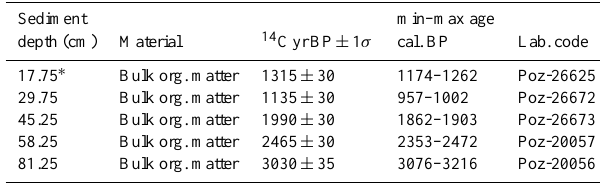
Table 1. Radiocarbon dates and calibrated